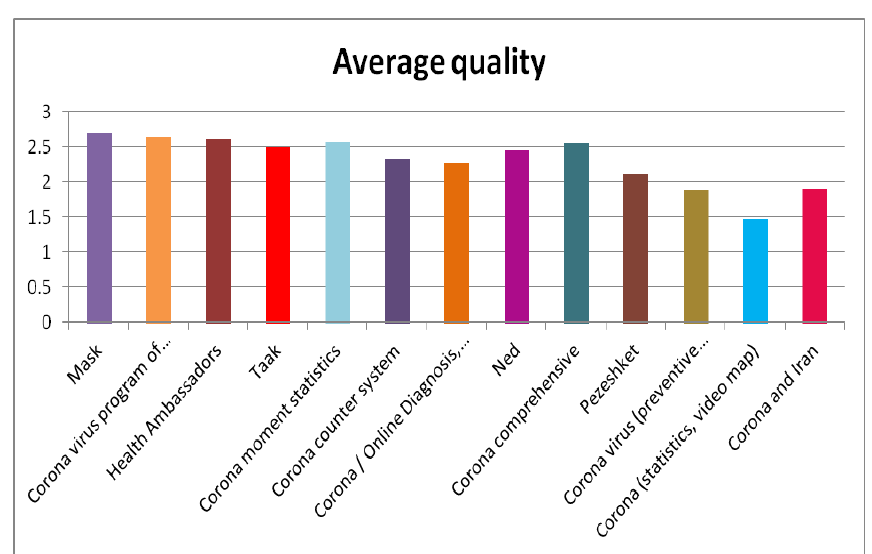
Fig 2. The average scores of the quality of indicators in 13 Apps according to MARS